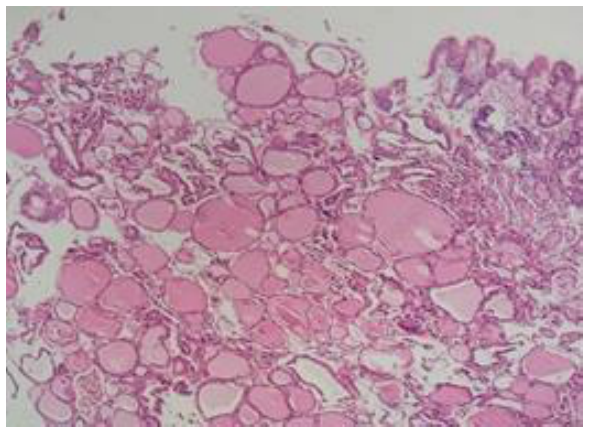
Fig 1. Thyroid nodule composed of follicular cells and colloid (H&E) The TFCs was flat and had small size nuclei. Immunohistochemical staining for thyroglobulin (Tg) was performed to confirm follicular thyroid cells (Figure 2).